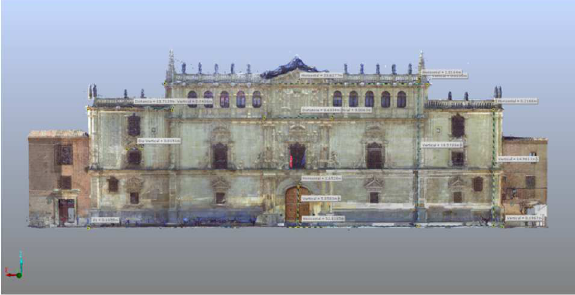
Figure 12: Work process image (orthophoto model